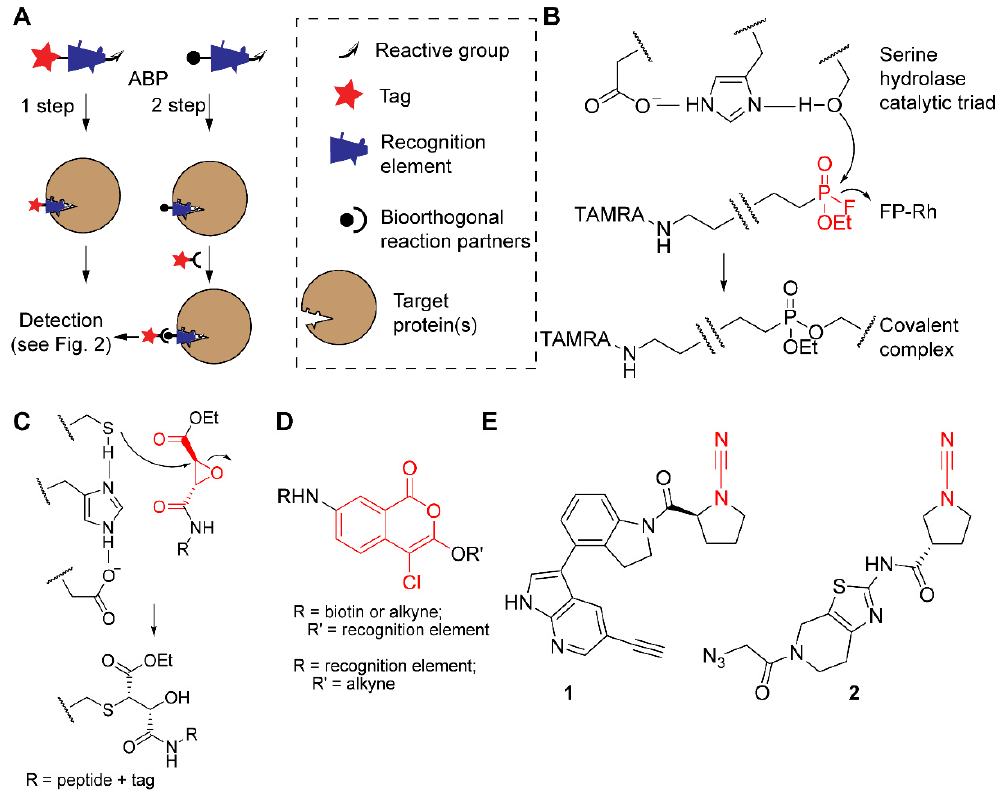
Figure 1. The concept of ABPP and examples of probes and reactive groups. ( A ) Schematic representation of one- and two-step ABPs with their three structural elements (tag or bioorthogonal handle, recognition element, and reactive group) and binding of a target protein by the recognition element. ( B ) Example of the fluorophosphonate probe FP-Rh (reactive group in red) and the covalent reaction mechanism with the active site of a serine hydrolase. ( C ) Example of epoxysuccinate probes (reactive group in red) and the covalent reaction mechanism with the active site of a cysteine protease. ( D ) Structure of probes based on the 4-chloro-isocoumarin scaffold (in red) for serine proteases, with tags and recognition elements at different positions. ( E ) Two examples of cyanimide probes for the DUB UCHL1 (reactive cyanimide group in red).